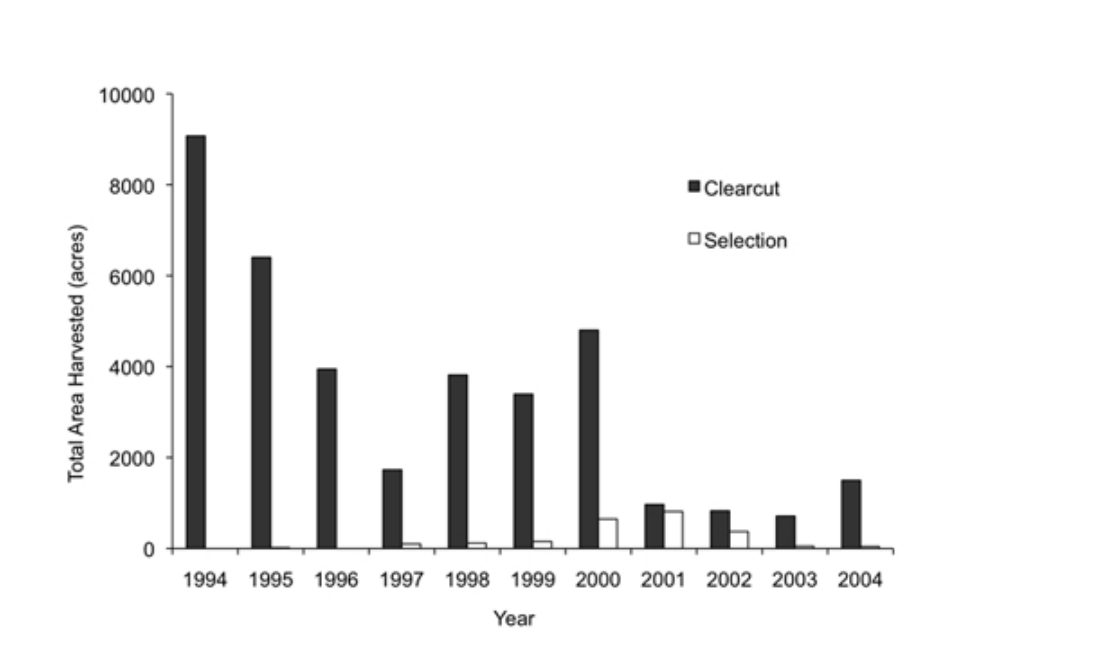
Fig. 7 . Estimated land area harvested by clear-cut and selection methods in the Tongass National Forest,